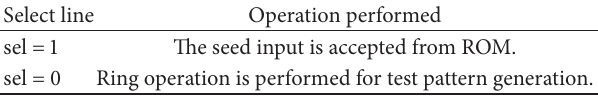
Table 1: Operation performed by modified FF.